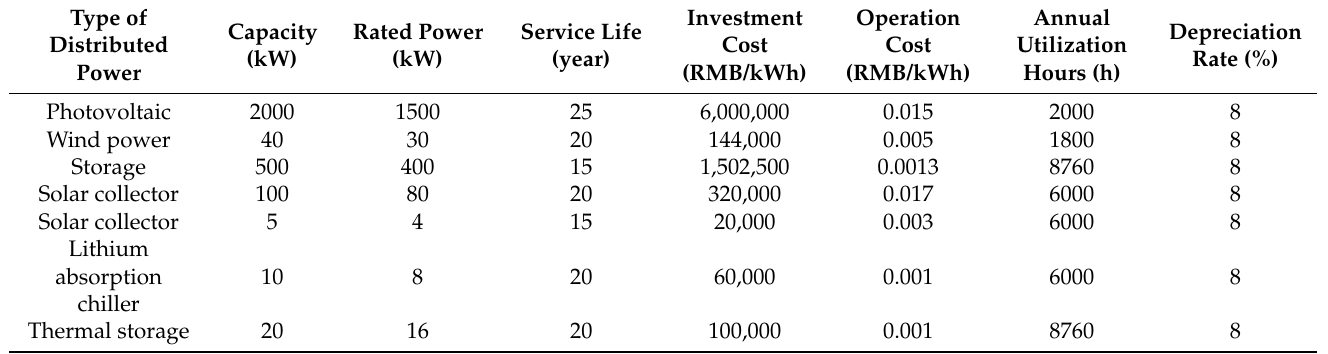
Table 2. Parameters of distributed